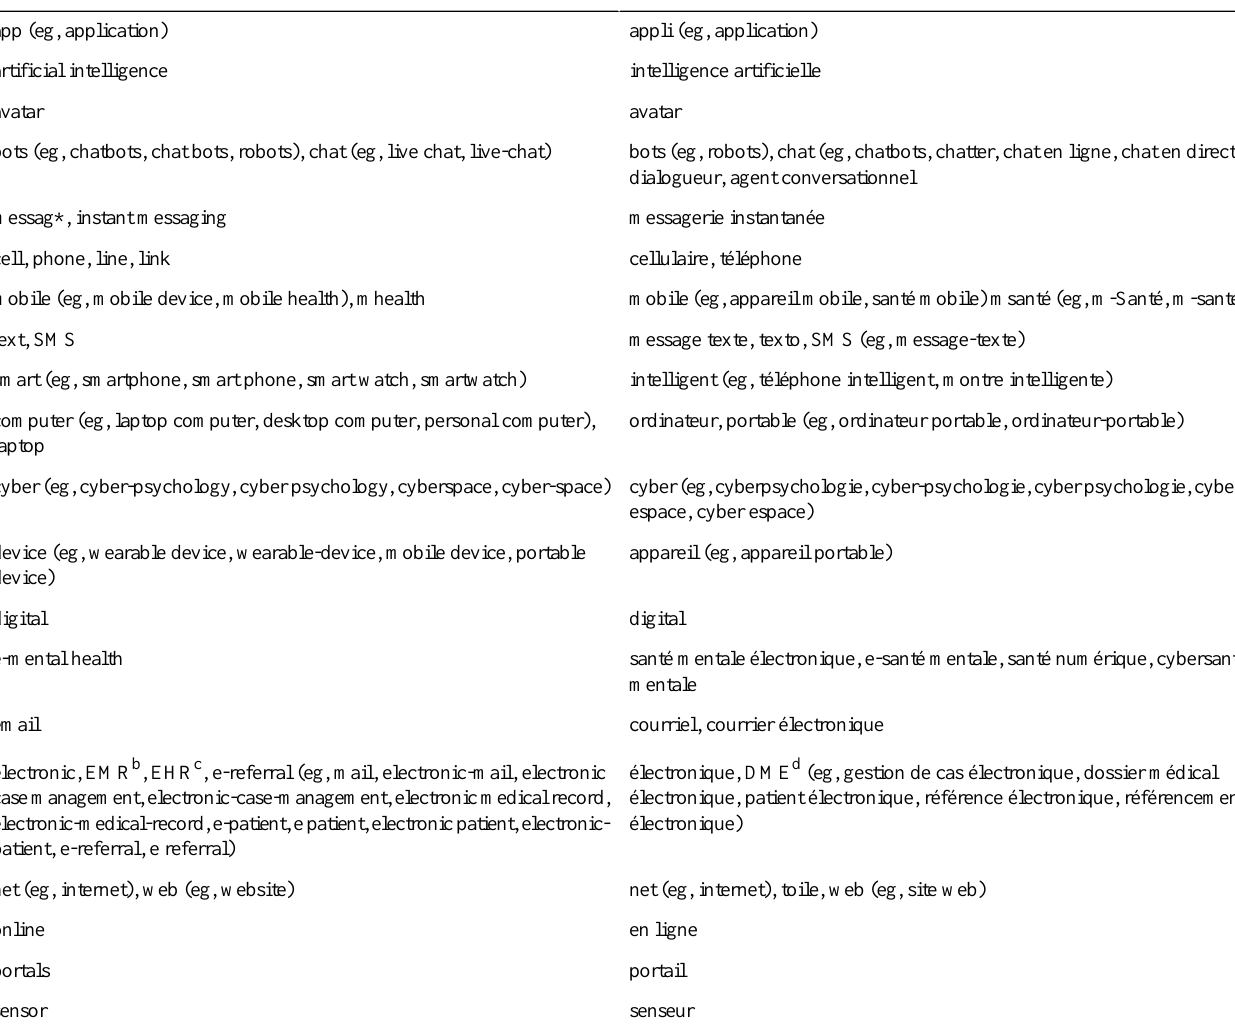
Keywords list (French)